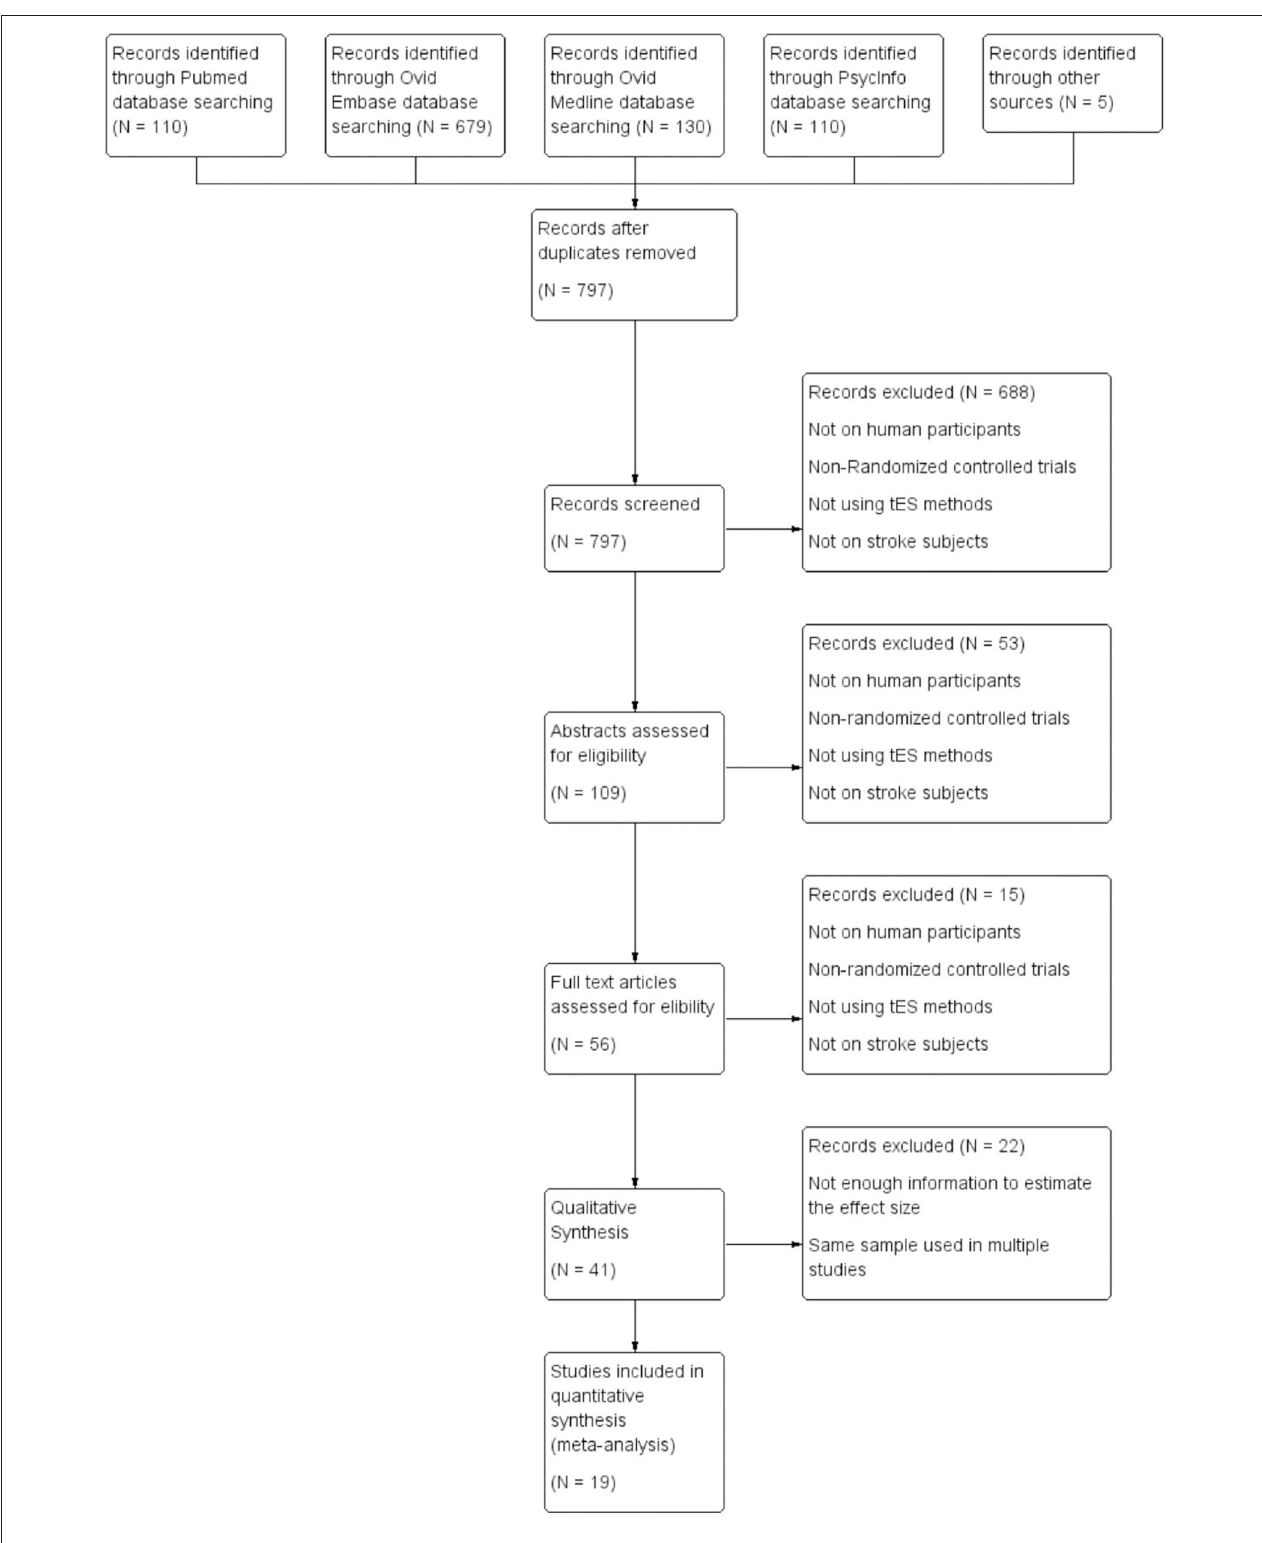
FIGURE 1 | Flow chart of selection of